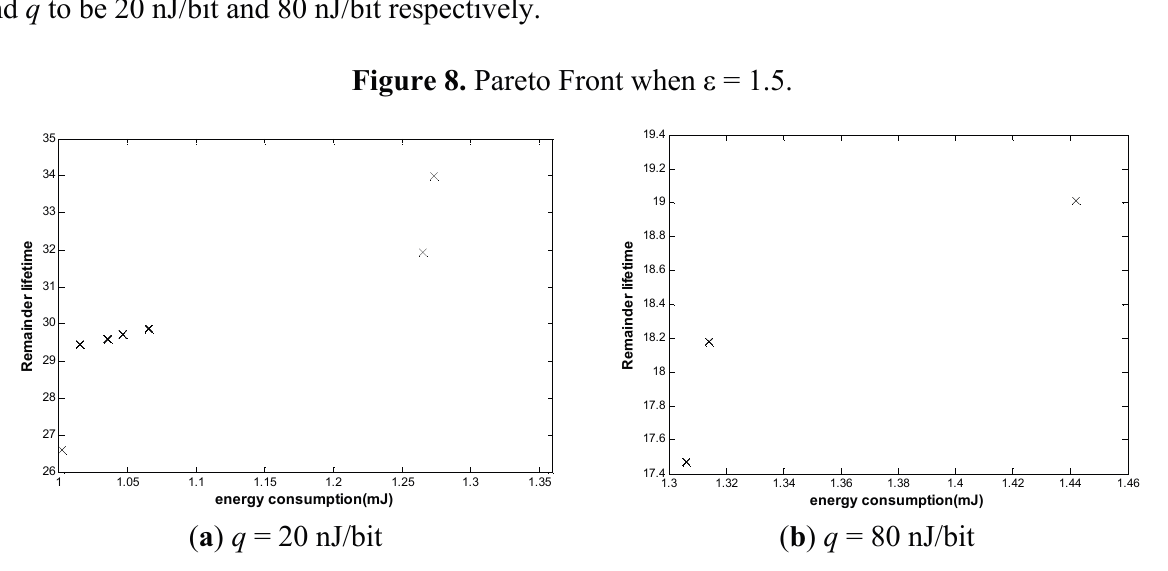
Figure 7. Impact of r